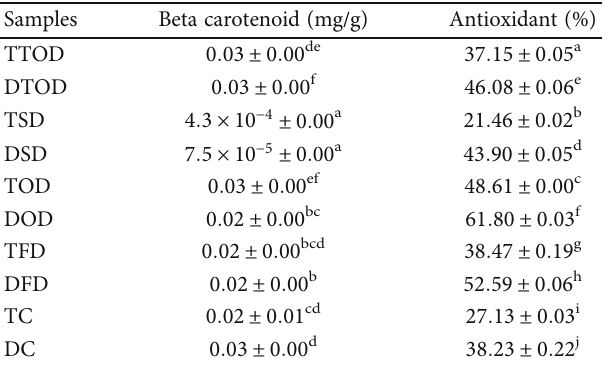
Table 3: Beta-carotene and antioxidant properties of oil palm fruit mesocarp. Samples Beta carotenoid (mg/g) Antioxidant